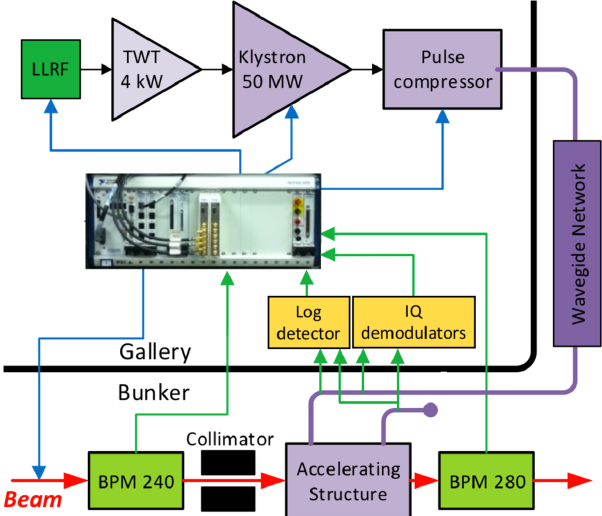
FIG. 1. Simplified layout of the hardware installation, control and acquisition